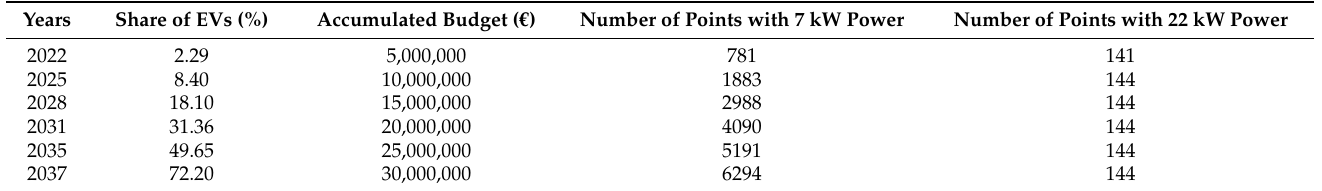
Table 1. Number of EV charging points per power.